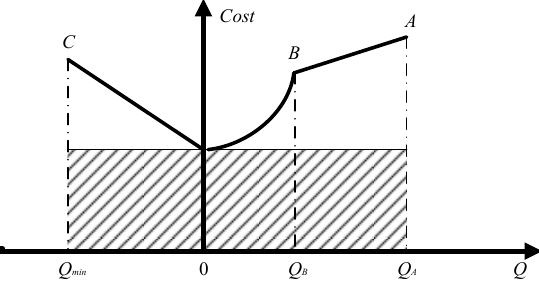
Figure 2. Comprehensive cost curve of the synchronous condenser.